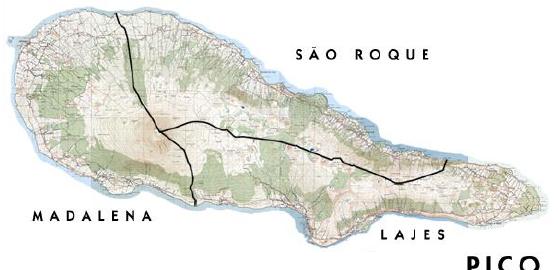
Figure 1. The three municipalities united in the Volcano. Source: Inventário do Património Imóvel dos Açores.